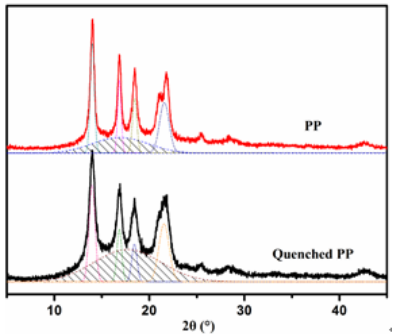
ff raction patterns of PP before and after the quenching Figure 4. X-ray diffraction patterns of PP before and after the quenching treatment. Figure 4. X-ray di